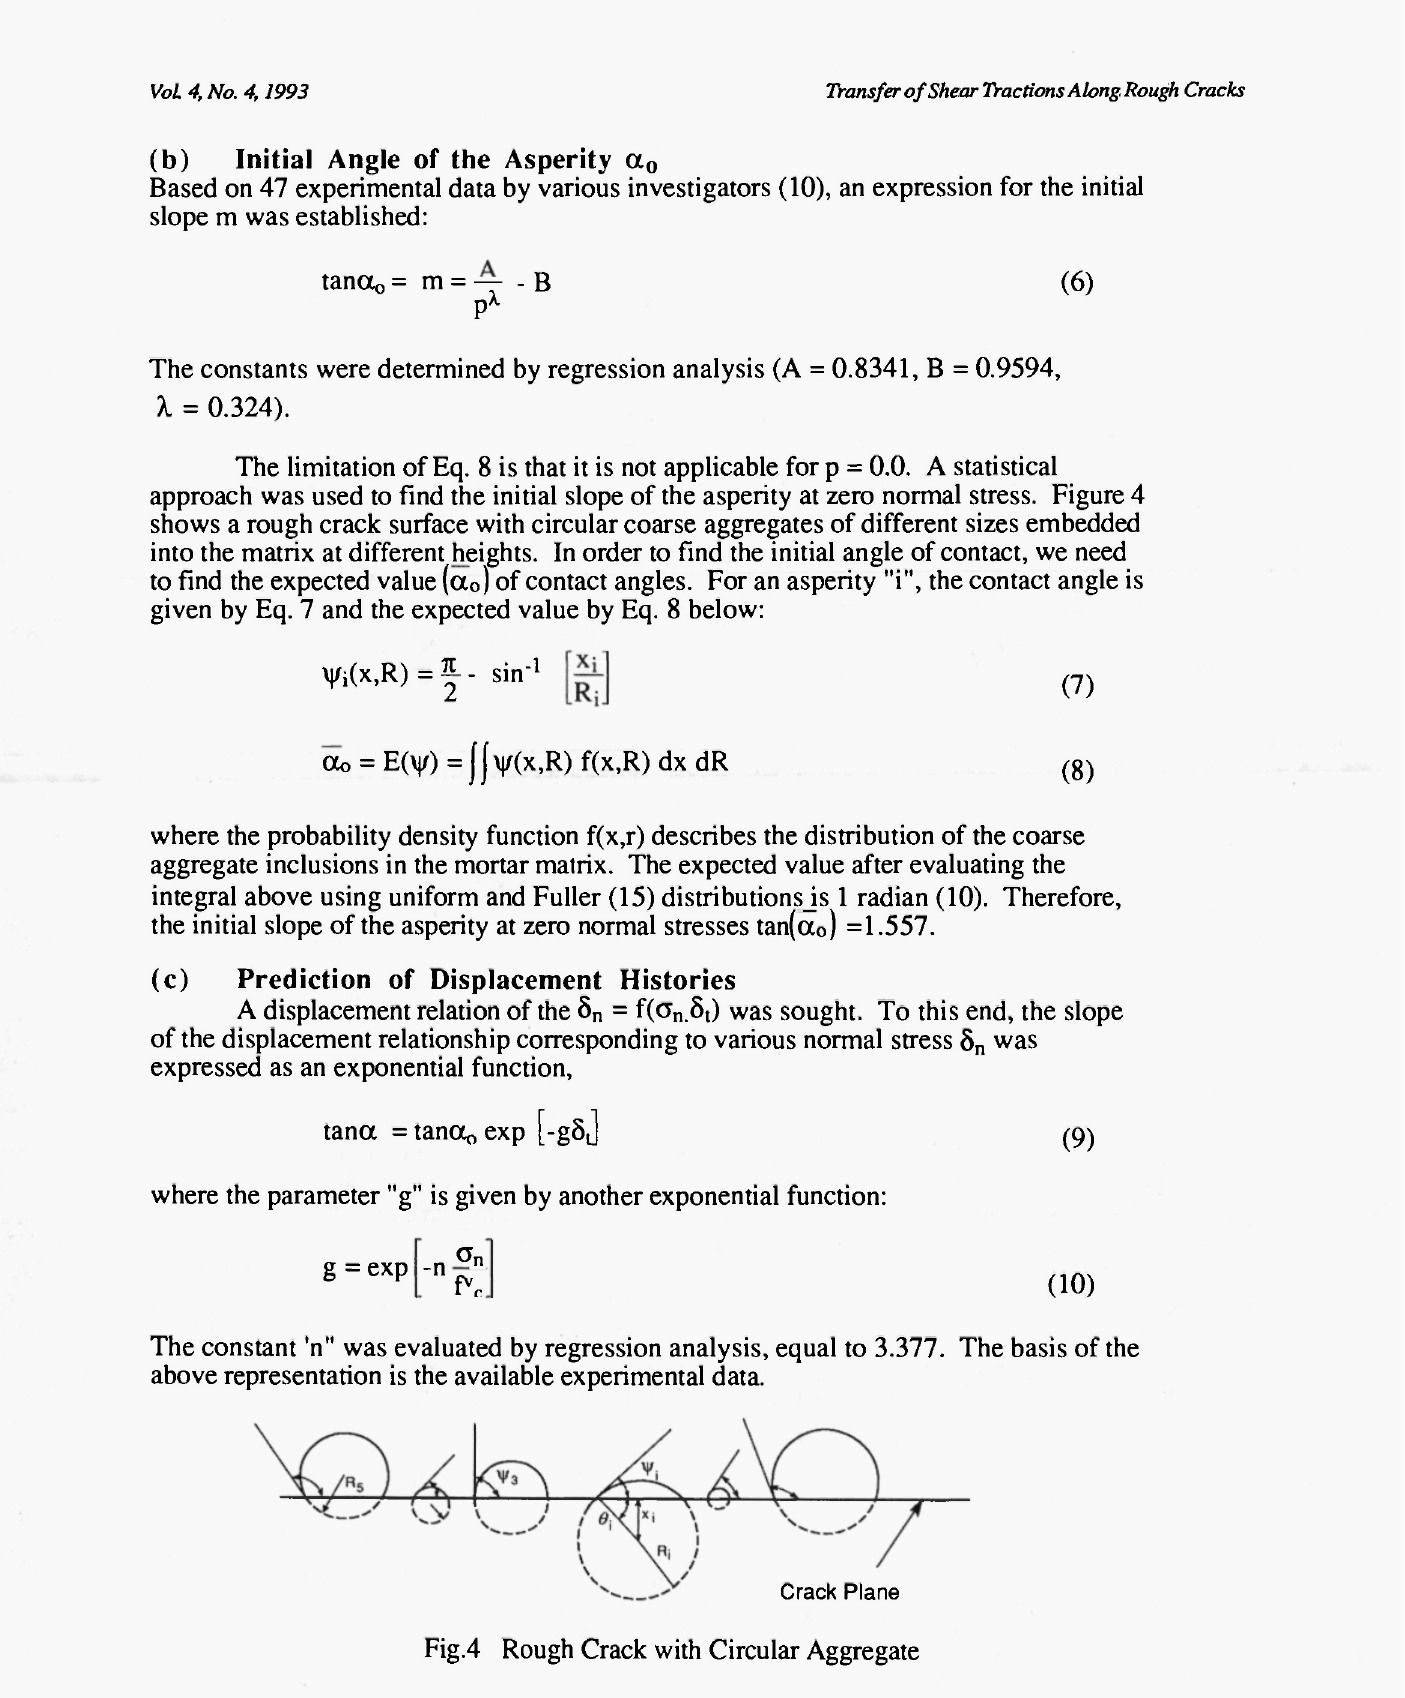
Fig.4 Rough Crack with Circular